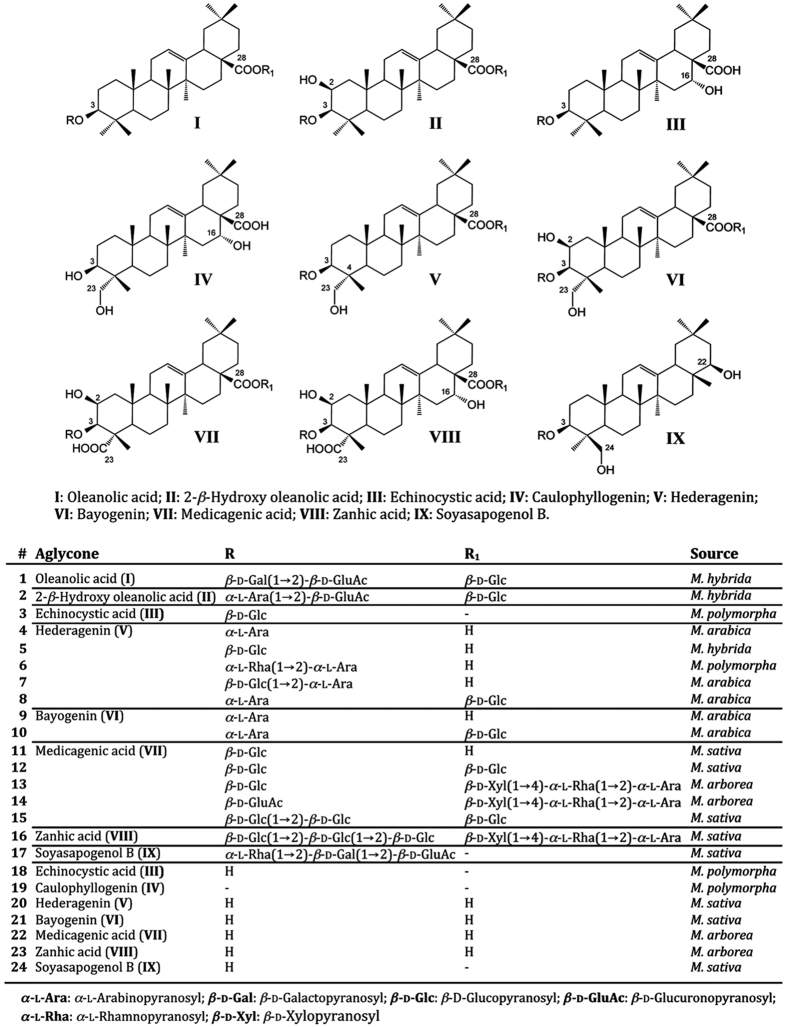
Structure and classification of saponins (1–17) and sapogenins (18–24) used in this investigation.